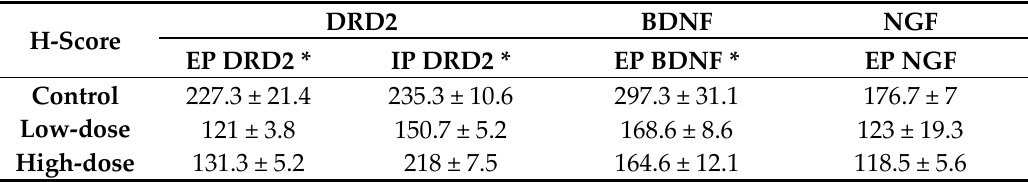
Figure 1. Prefrontal cortex DRD2 immunostaining. Control ( A ), low-dose metoclopramide ( B ), high- dose metoclopramide ( C ). m: molecular layer, e: external pyramidal layer, i: internal pyramidal layer (1) ×100,  : external pyramidal neurons,  : internal pyramidal neurons, external pyramidal layer (2), internal pyramidal layer (3). ×400. Table 1. DRD2, BDNF, NGF H-score levels in the brain prefrontal cortex of infant rats in the control and low- and high-dose metoclopramide